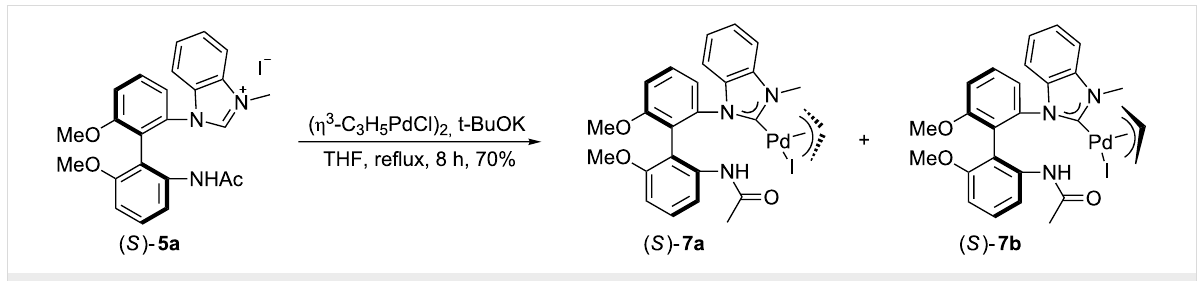
Scheme 2: Synthesis of mono(NHC)–Pd(II) complex.